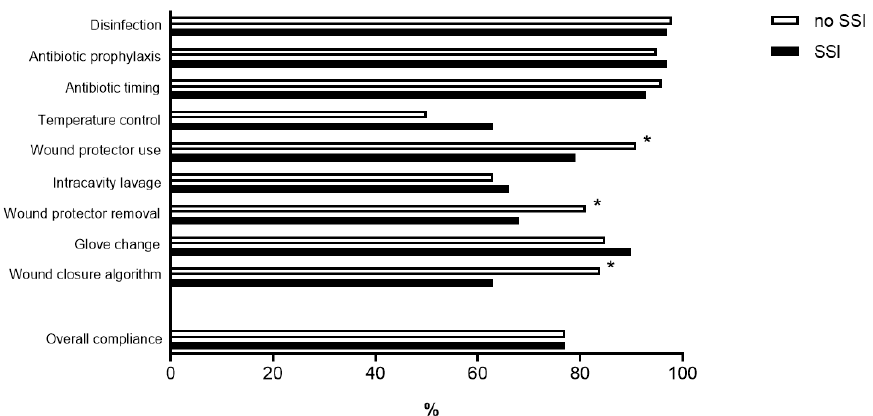
Figure 1. Compliance with the SSI prevention bundle. Compliance in % to individual items of the institutional SSI prevention bundle in patients without SSI ( n = 202, grey bars) and patients with SSI ( n = 58, black bars). * indicate statistically significant differences ( p < 0.05). *: p < 0.001